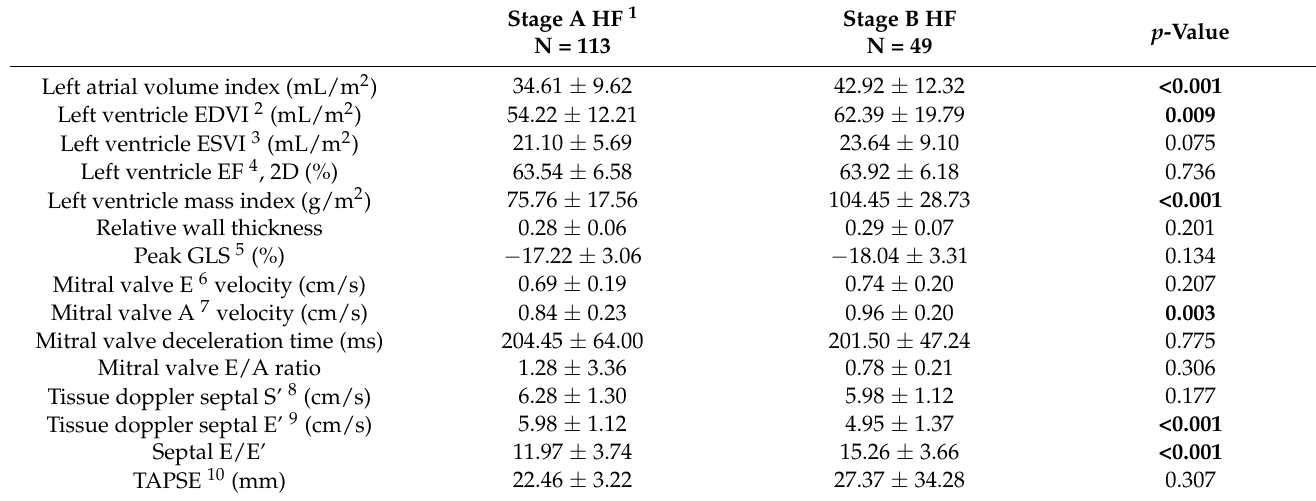
Table 2. Echocardiographic parameters of both groups.